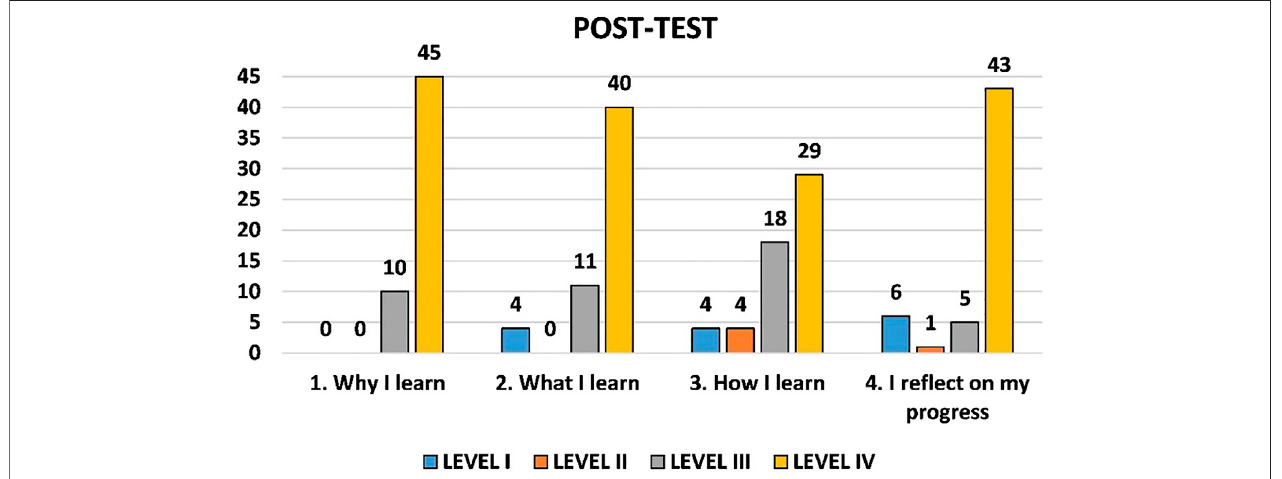
FIGURE 7 | Acquiring learning to learn competence (posttest) by dimension and level of progression ( N (cid:1) 55).